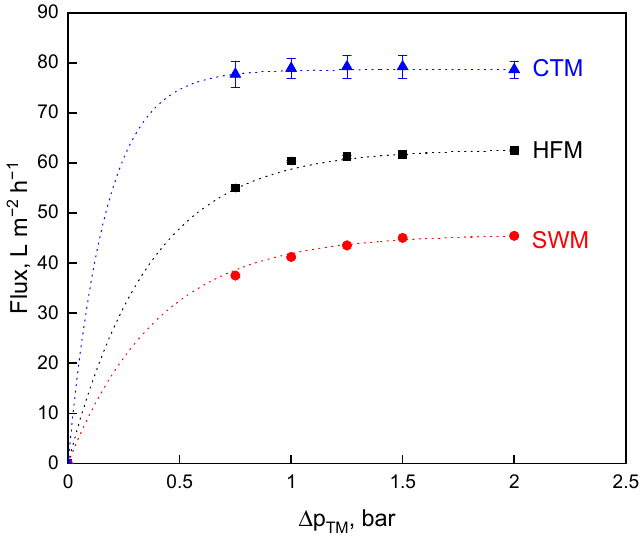
Figure 2. Flux as a function of the transmembrane pressure, ∆ p TM , for spiral wound membrane (SWM; • ), ceramic tubular membrane (CTM; ▲ ), and hollow fiber membrane (HFM; ■ ) at a pressure drop of ∆ p L = 1.3 bar·m − 1 .